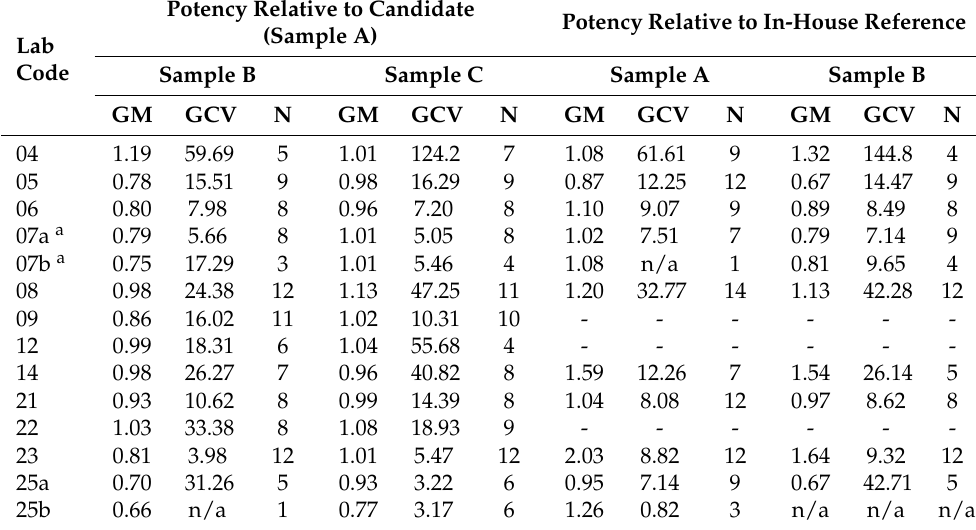
Table 6. Individual laboratory geometric mean relative potency estimates for HUVEC assays.